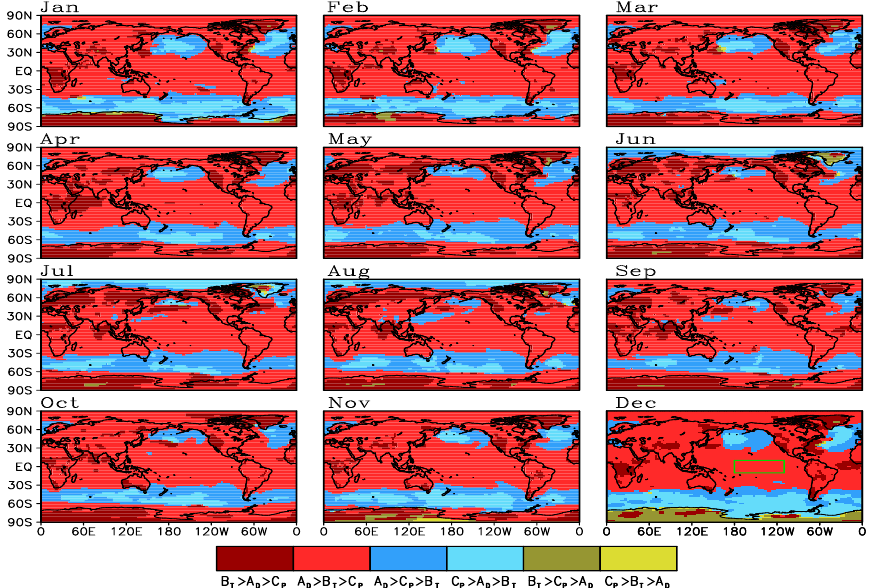
Figure 4. Geographical distributions of the three types (in red, blue, and yellow) and the final six patterns for dominance analysis in terms of the comparison among the coefficients A D , B T , and C P . In the last plot for December, a region with the box marked in green is selected for use in Figure 5.